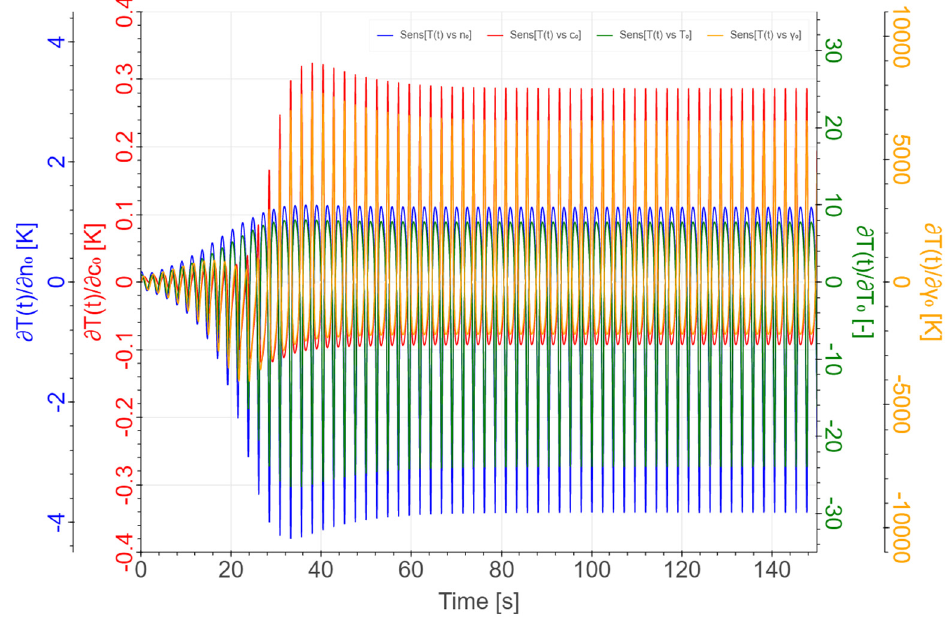
( ) T t with respect to the initial conditions